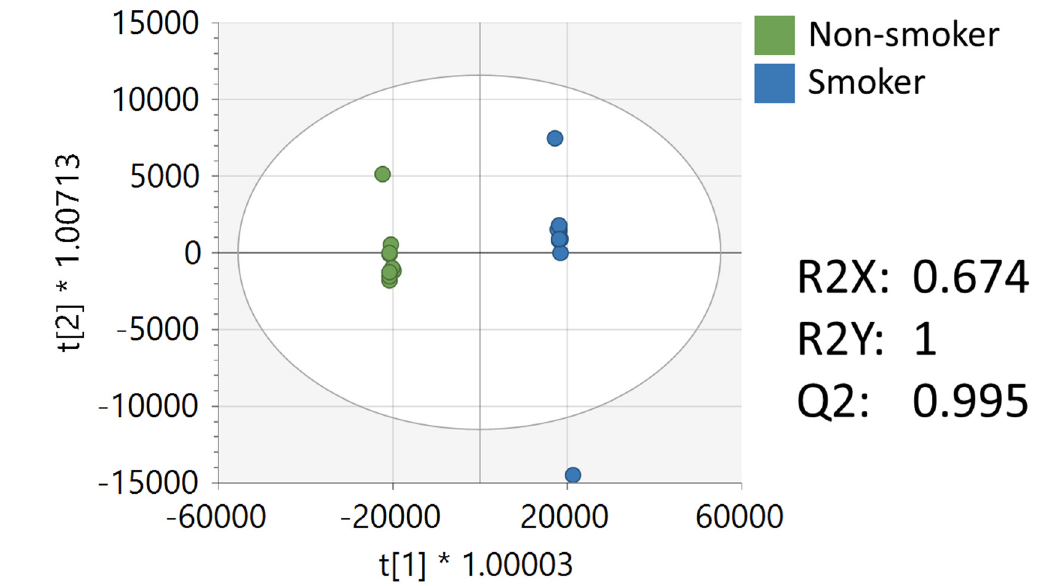
Figure 2. OPLS-DA of metabolomics data of NIST smoker and non-smoker urine reference materi- als.